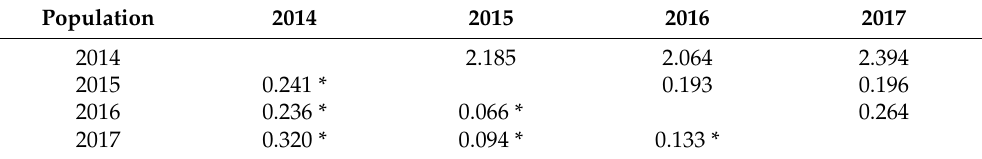
Table 4. Pairwise genetic distance (above) and F ST values (below) of four